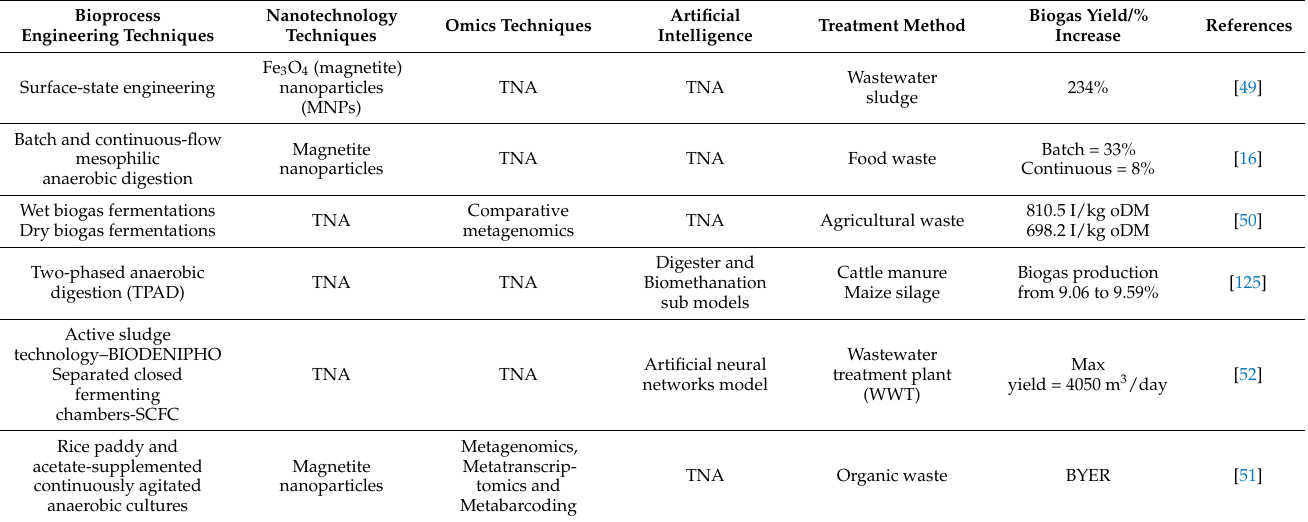
Table 1. A snapshot of some of the multidisciplinary research pioneered in addressing waste